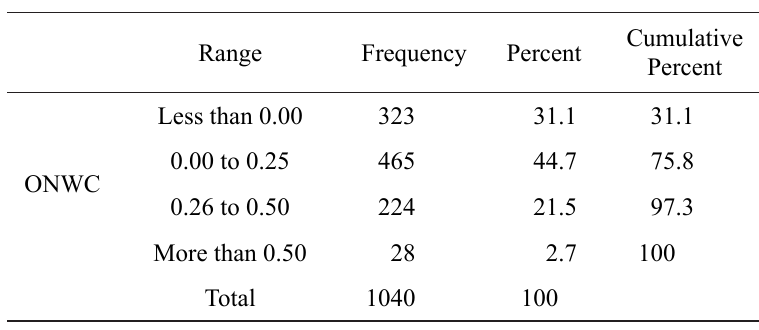
Cumulative Percent